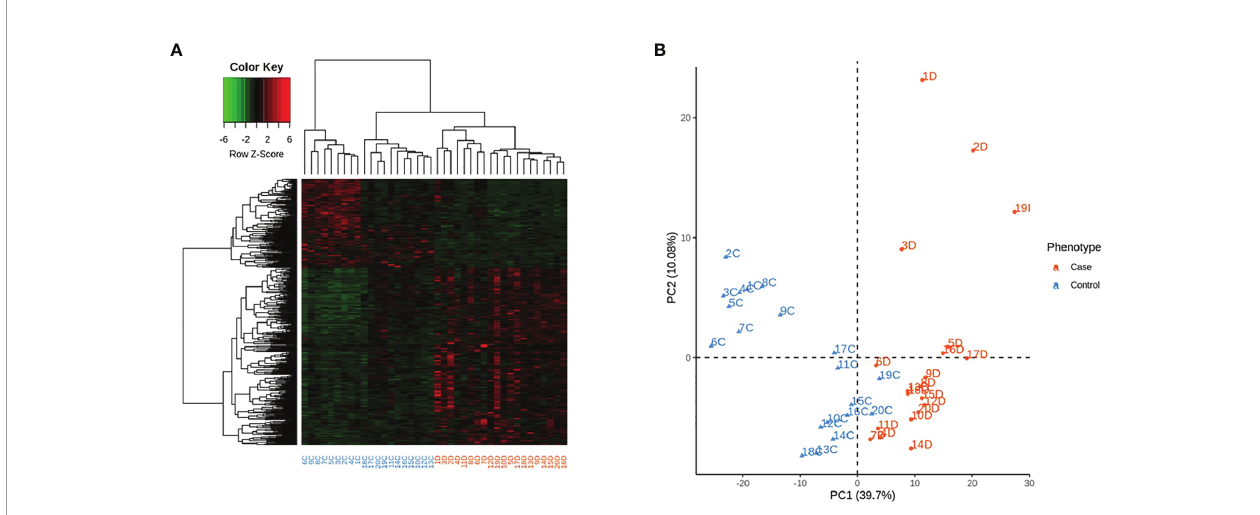
FIGURE 1 | Expression of the 346 differentially expressed genes (DEG) across the 40 samples, according to their phenotype. Control identi fi ers are written in blue, and case identi fi ers in orange. (A) Complete-linkage hierarchical clustering (HCA) based on spearman correlation. (B) First two components of principal component analysis